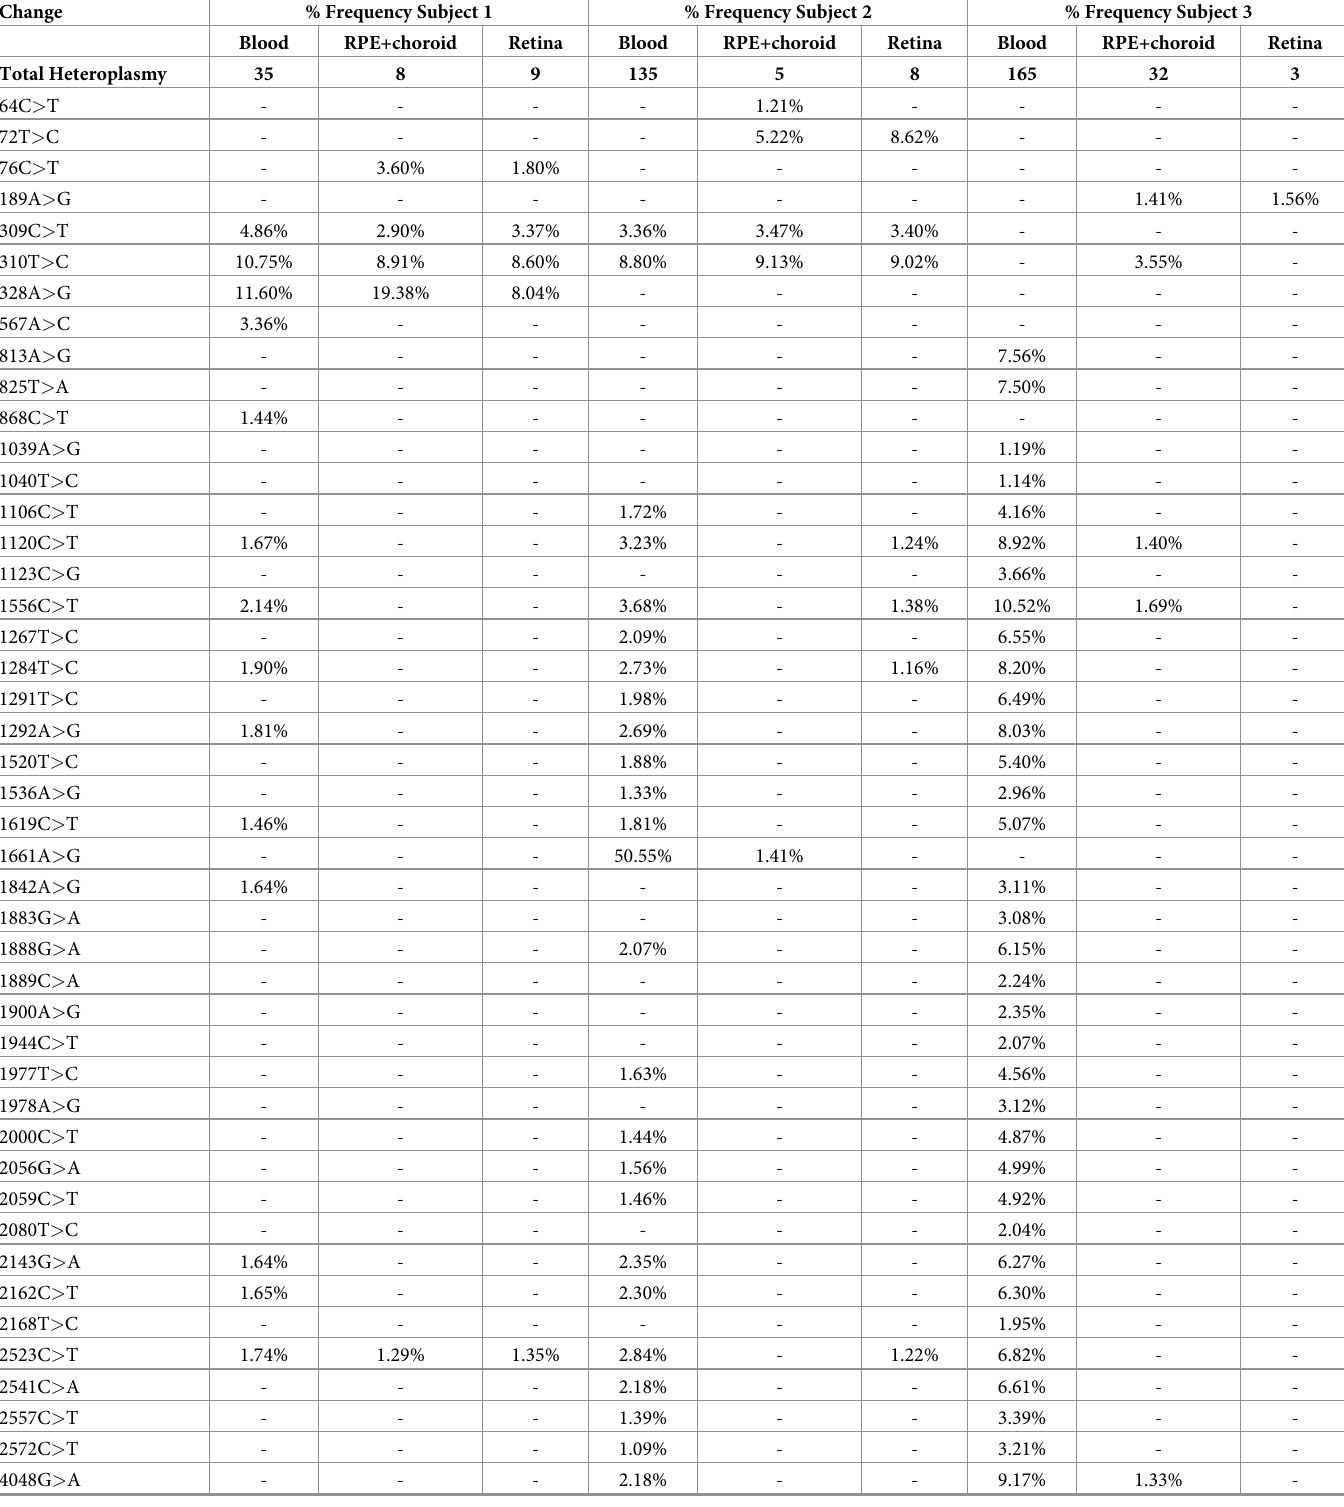
Table 5. List of heteroplasmy SNPs found in different tissues and subjects.